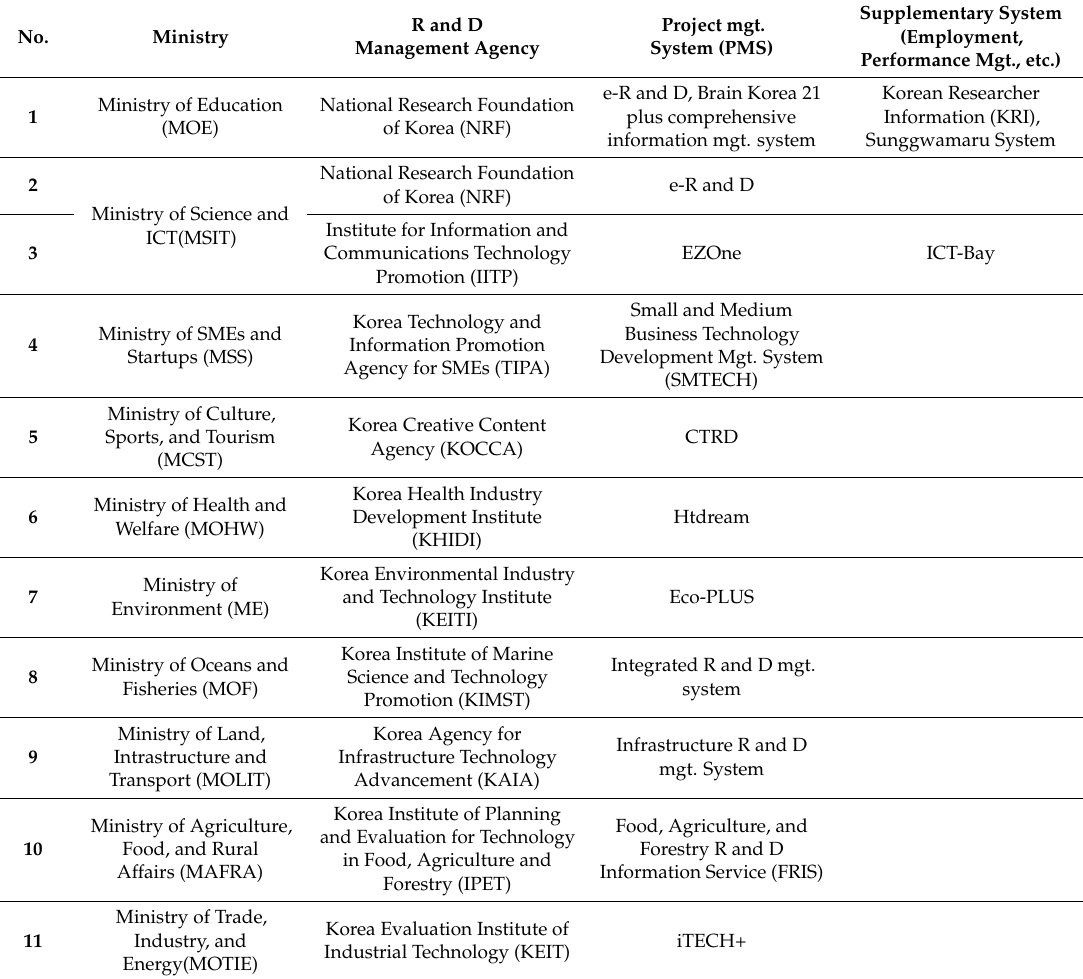
Table 5. Current status of project-management systems